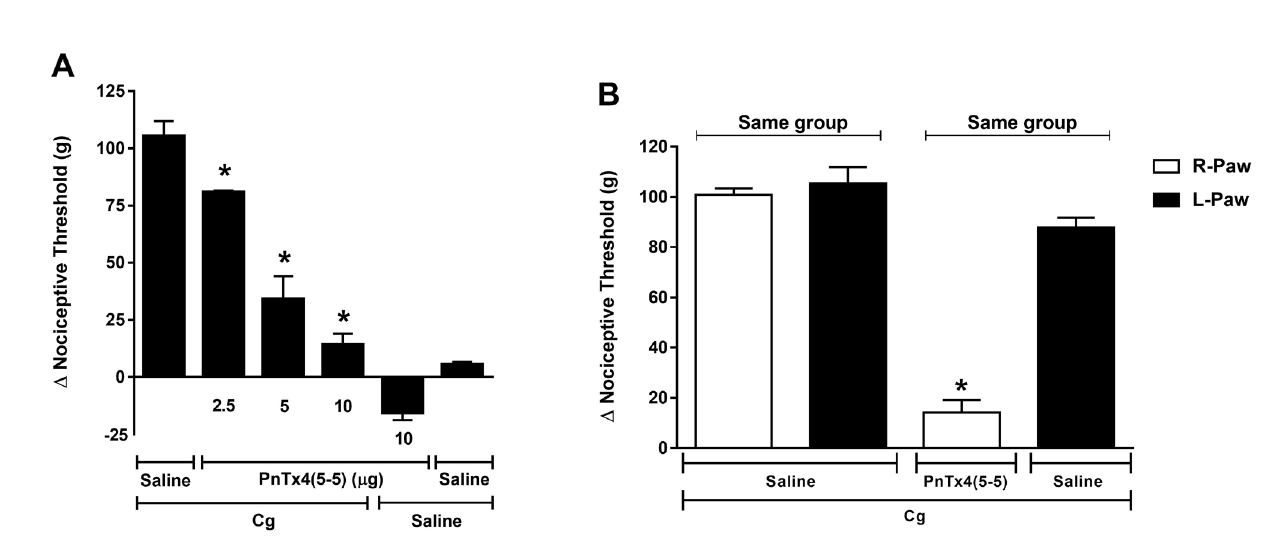
Figure 2. Effect of PnTx4(5-5) on carrageenan induced hyperalgesia. ( A ) Effect of intraplantar administration of different doses of PnTx4(5-5) (2.5, 5 and 10 µg) on hyperalgesia induced by carrageenan (Cg – 250 µg/paw). PnTx4(5-5) was administered 150 minutes after Cg injection. Exclusion of systemic antinociceptive effect of PnTx4(5-5) at a dose of 10 µg. ( B ) Toxin or saline were injected into the right paw (RP) 150 minutes after administration of Cg (250 µg) in both hind paws (RP/LP). Each column represents the mean ± S.E.M. of Δ nociceptive threshold (g) for four animals. *Indicates statistical significant difference (p < 0.05) from the group control (Cg + saline –